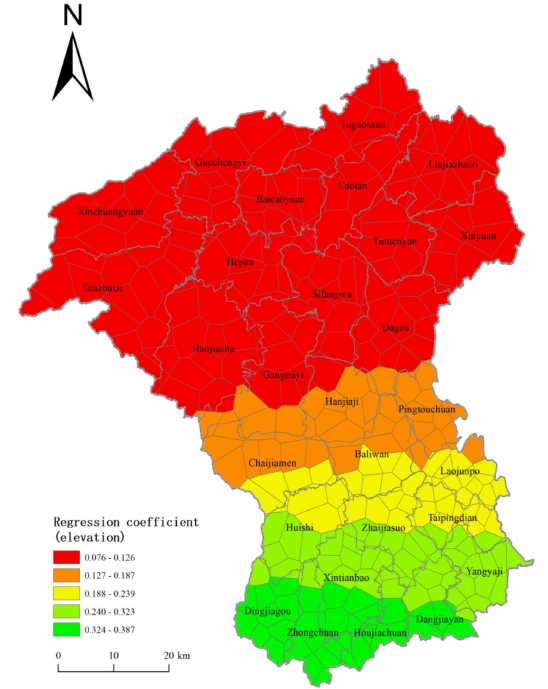
Figure 6. The GWR coe ffi cients between rural poverty and topography in the GWR